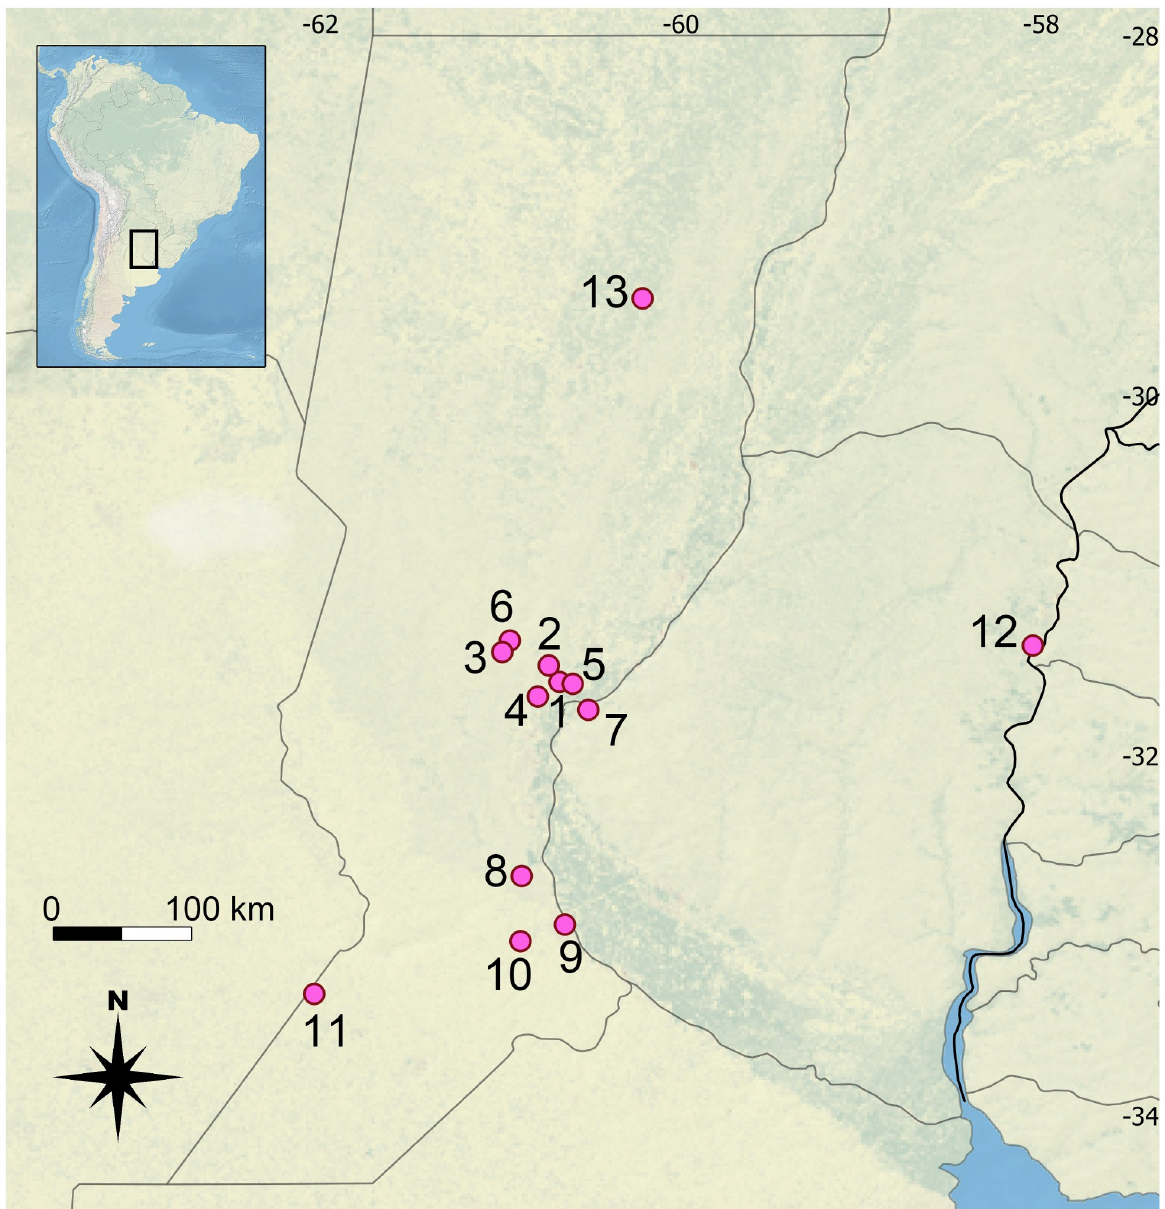
Fig 1. Sampling localities. Map showing sampling localities: Santa Fe (1), Recreo (2), Esperanza (3), Santo Tome´ (4), San Jose´ de Rinco´n (5), Cululu´ (6), Parana´ (7), Pueblo Andino (8), Rosario (9), Zavalla (10), Cha ñ ar caı´do (11), Concordia (12), and Vera (13).